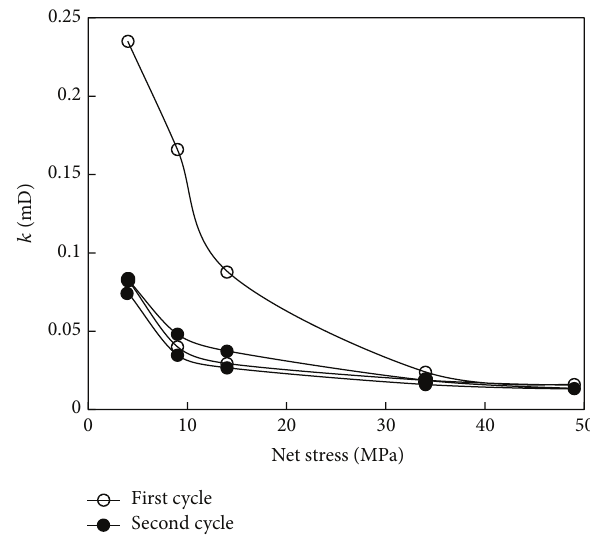
Figure 6: Permeability versus net stress in aging